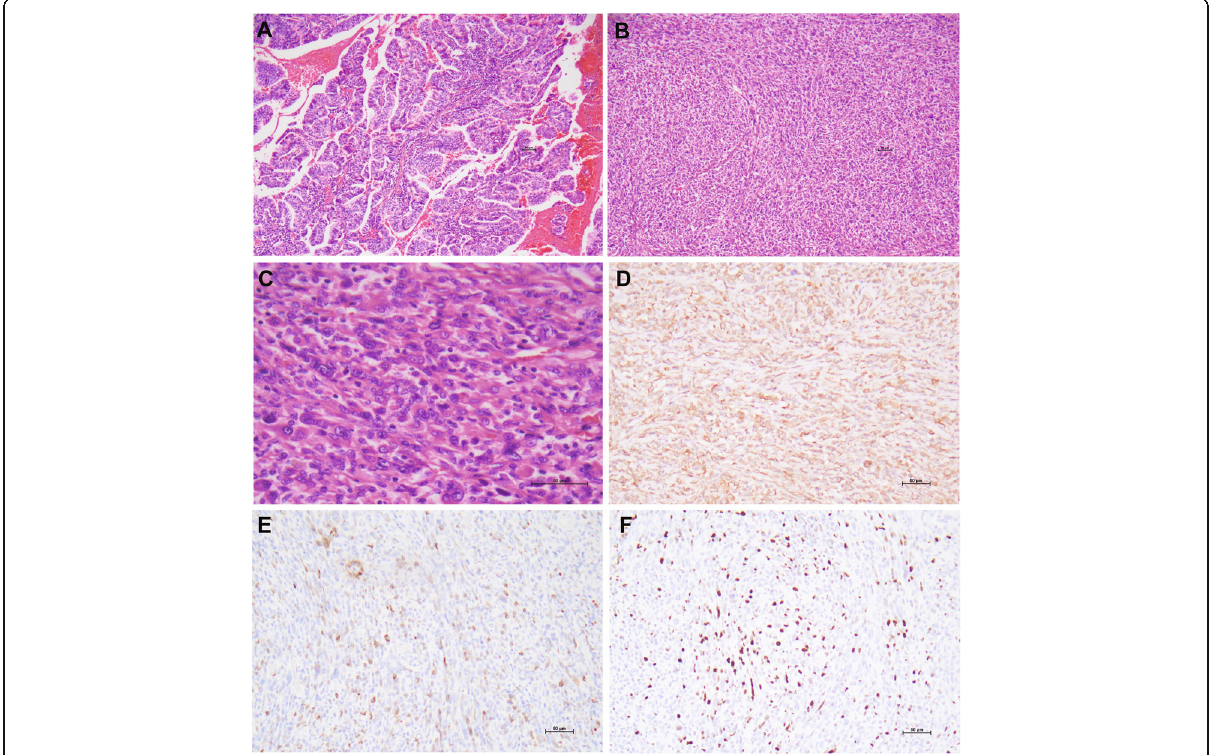
Fig. 3 Ovarian mucinous tumor with sarcoma-like mural nodules (patient 3). A well differentiated mucinous adenocarcinoma exhibits the confluent growth of interconnecting papillae [ a ]. The mural nodule is composed of atypical spindle cells arranged in a vaguely fascicular pattern [ b , c ]. The tumor cells in the mural nodule are vimentin+ [ d ], CK focal+ [ e ], and have a high Ki-67 index [ f ]. (H&E: a , b × 100, c × 200; immunohistochemistry, d - f ×